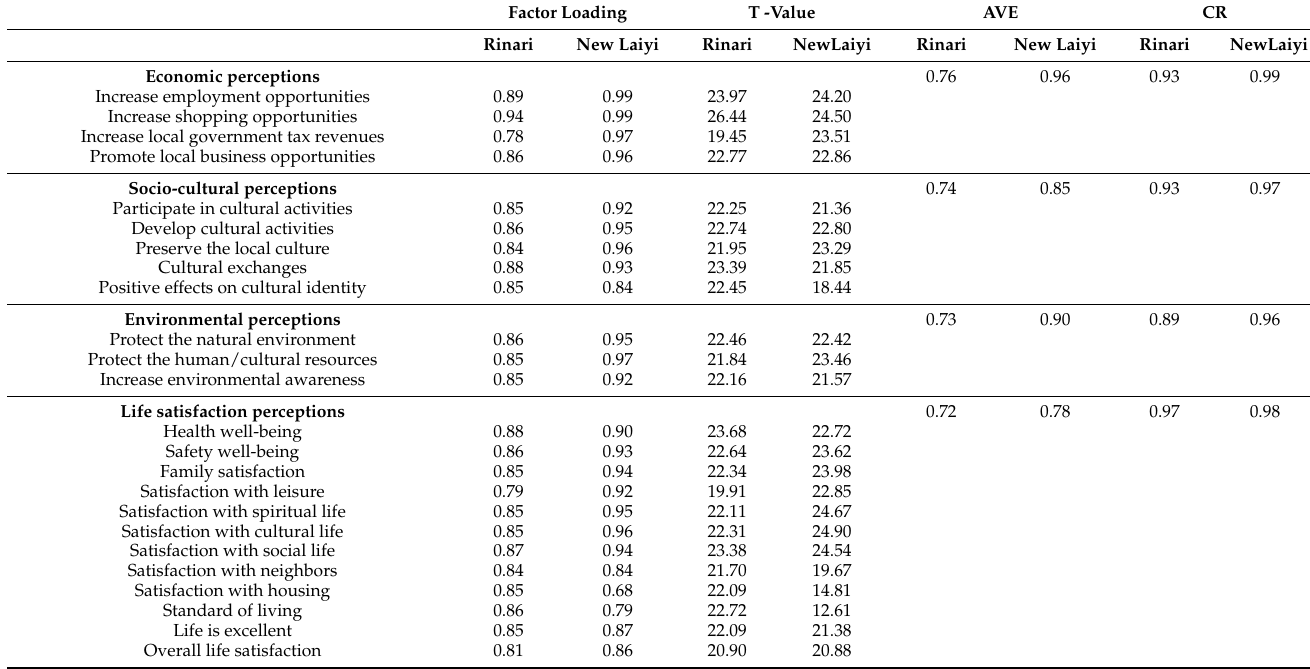
Table 3. Outcomes of confirmatory factor